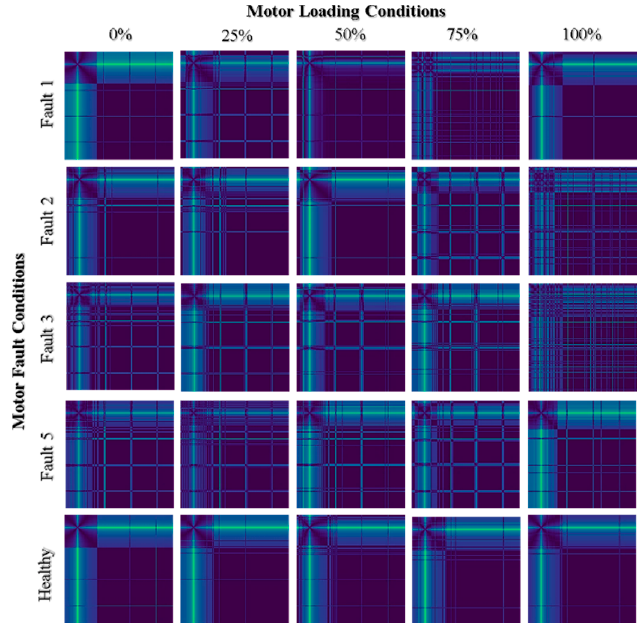
Figure 10. Sample frequency occurrence plots of five motor fault conditions under five loading Figure10. conditions.